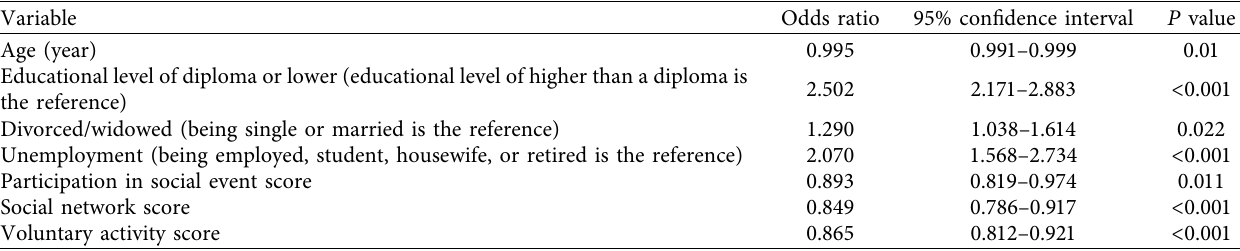
Table 3: Results of binary logistic regressions to determine the factors associated with food insecurity.